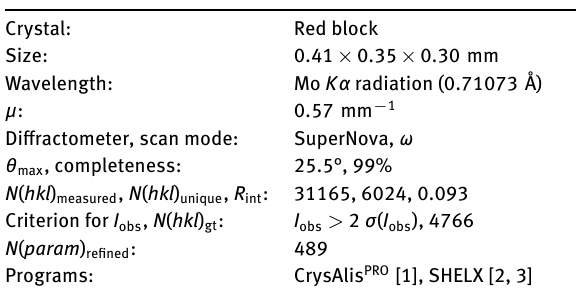
Table 1: Data collection and handling.